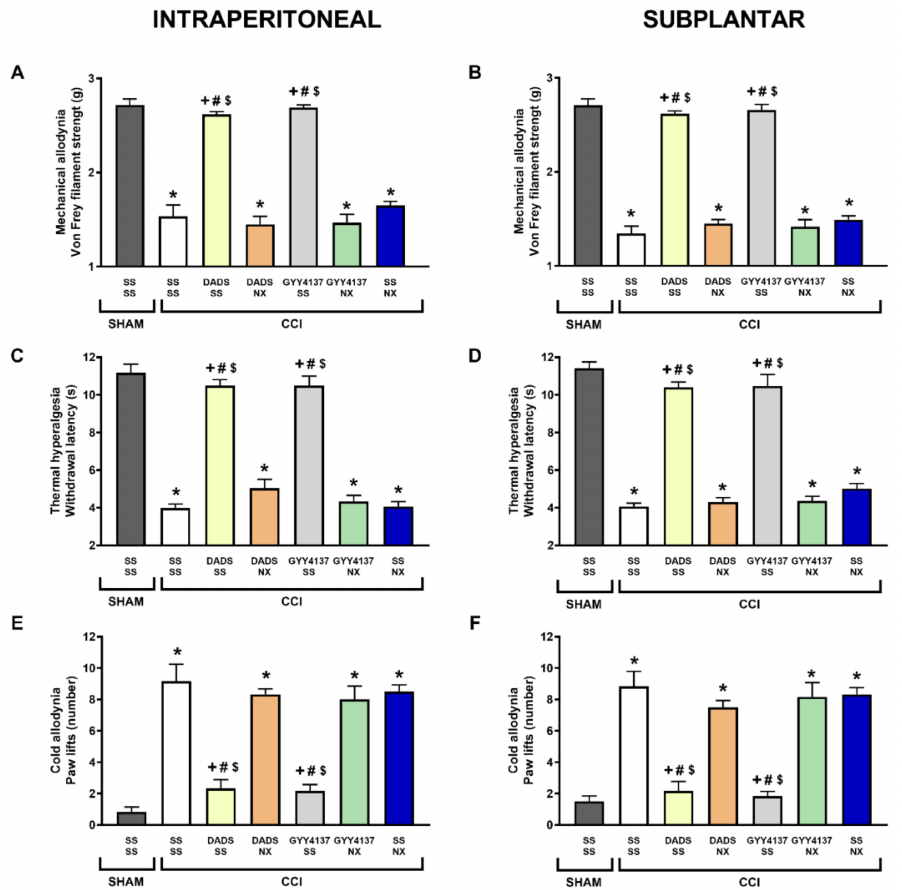
Figure 3. Reversal of the antiallodynic and antihyperalgesic effects of DADS and GYY4137 by naloxone during neuropathic pain. The inhibitory actions produced by i.p. injection of DADS (30 mg/kg) or GYY4137 (24 mg/kg) alone, and combined with naloxone (NX) intraperitoneally (3 mg/kg) ( A , C , E ) or subplantarly injected (20 µ g) ( B , D , F ) in mice with CCI-provoked neuropathic pain, are represented. Sham-operated (SHAM) animals treated with SS plus SS are also represented. For each test, * represents significant differences vs. SHAM-animals treated with SS plus SS, + vs. CCI-mice treated with SS plus SS, # vs. CCI-mice treated with DADS or GYY4137 plus NX, and $ vs. CCI-mice treated with SS plus NX ( p < 0.05; one-way ANOVA, followed by Tukey test). Each column represents the mean, and vertical bars indicate SEM ( n = 6 animals for